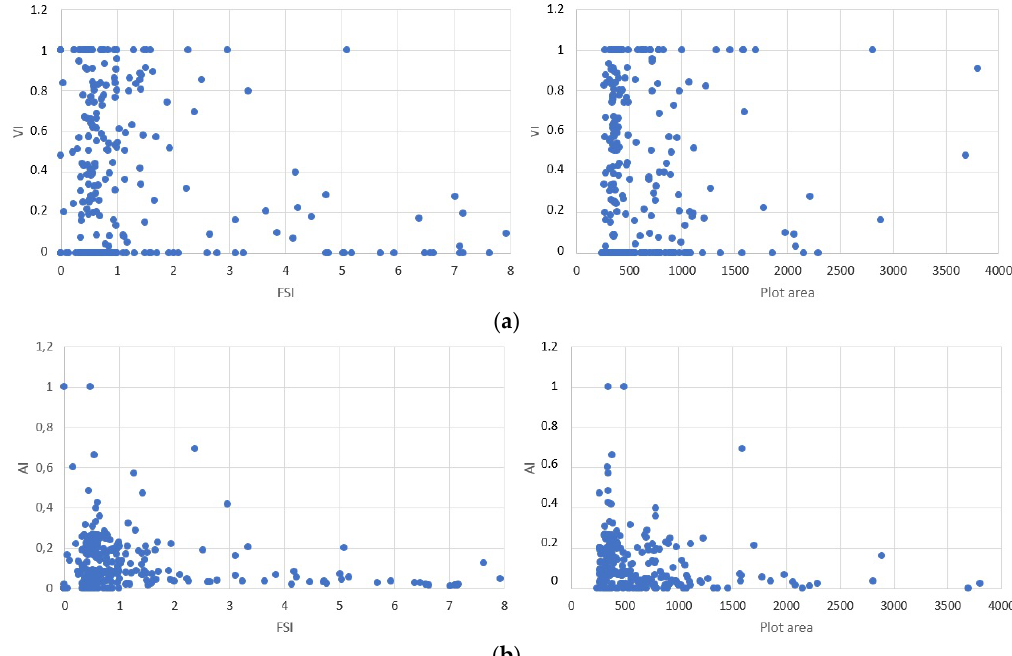
Figure 8. ( a ) On the left, chart with relation, per plot, between FSI on the x-axis and Visibility Index (VI) on the y-axis. On the right, chart with relation, per plot, between plot size on the x-axis and Visibility Index (VI) on the y-axis; ( b ) On the left, chart with relation, per plot, between FSI on the x-axis and Accessibility Index (AI) on the y-axis. On the right, chart with relation, per plot, between plot size on the x-axis and Accessibility Index (AI) on the y-axis.